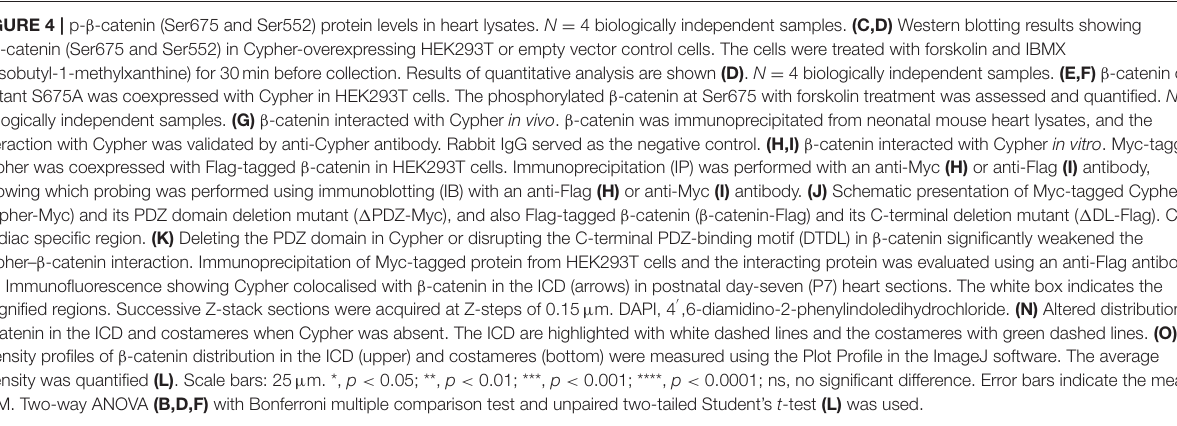
FIGURE 4 | p- β -catenin (Ser675 and Ser552) protein levels in heart lysates. N = 4 biologically independent samples. (C,D) Western blotting results showing p- β -catenin (Ser675 and Ser552) in Cypher-overexpressing HEK293T or empty vector control cells. The cells were treated with forskolin and IBMX (3-isobutyl-1-methylxanthine) for 30min before collection. Results of quantitative analysis are shown (D) . N = 4 biologically independent samples. (E,F) β -catenin or its mutant S675A was coexpressed with Cypher in HEK293T cells. The phosphorylated β -catenin at Ser675 with forskolin treatment was assessed and quantified. N = 3 biologically independent samples. (G) β -catenin interacted with Cypher in vivo . β -catenin was immunoprecipitated from neonatal mouse heart lysates, and the interaction with Cypher was validated by anti-Cypher antibody. Rabbit IgG served as the negative control. (H,I) β -catenin interacted with Cypher in vitro . Myc-tagged Cypher was coexpressed with Flag-tagged β -catenin in HEK293T cells. Immunoprecipitation (IP) was performed with an anti-Myc (H) or anti-Flag (I) antibody, following which probing was performed using immunoblotting (IB) with an anti-Flag (H) or anti-Myc (I) antibody. (J) Schematic presentation of Myc-tagged Cypher (Cypher-Myc) and its PDZ domain deletion mutant ( 1 PDZ-Myc), and also Flag-tagged β -catenin ( β -catenin-Flag) and its C-terminal deletion mutant ( 1 DL-Flag). C, cardiac specific region. (K) Deleting the PDZ domain in Cypher or disrupting the C-terminal PDZ-binding motif (DTDL) in β -catenin significantly weakened the Cypher– β -catenin interaction. Immunoprecipitation of Myc-tagged protein from HEK293T cells and the interacting protein was evaluated using an anti-Flag antibody. (M) Immunofluorescence showing Cypher colocalised with β -catenin in the ICD (arrows) in postnatal day-seven (P7) heart sections. The white box indicates the magnified regions. Successive Z-stack sections were acquired at Z-steps of 0.15 µ m. DAPI, 4 ′ ,6-diamidino-2-phenylindoledihydrochloride. (N) Altered distribution of β -catenin in the ICD and costameres when Cypher was absent. The ICD are highlighted with white dashed lines and the costameres with green dashed lines. (O) Intensity profiles of β -catenin distribution in the ICD (upper) and costameres (bottom) were measured using the Plot Profile in the ImageJ software. The average intensity was quantified (L) . Scale bars: 25 µ m. *, p < 0.05; **, p < 0.01; ***, p < 0.001; ****, p < 0.0001; ns, no significant difference. Error bars indicate the mean ± SEM. Two-way ANOVA (B,D,F) with Bonferroni multiple comparison test and unpaired two-tailed Student’s t -test (L) was